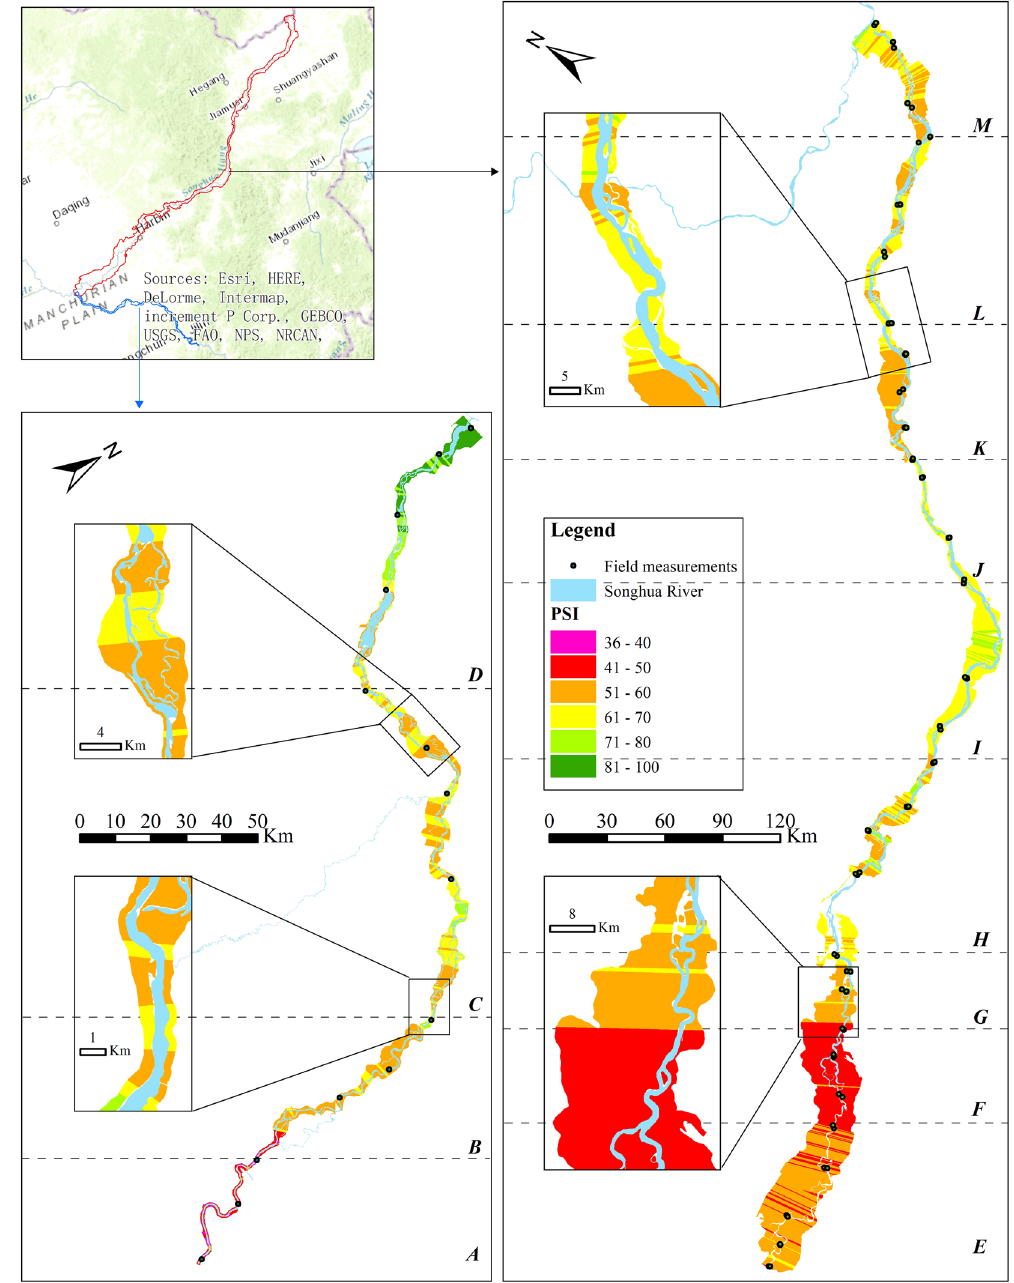
Figure 5. The spatial distribution of PSI values were derived from 2,081 BEUs. A-M represent the thirteen measurement sections. The map was prepared using ArcGIS 10.3 software (http://www.esri.com/software/ arcgis). The map is credited to: Esri, HERE, DeLorme, Intermap, increment P Corp., GEBCO, USGS, FAO, NPS, NRCAN, GeoBase, IGN, Kadaster NL, Ordnance Survey, Esri Japan, METI, Esri China (Hong Kong), swisstopo, MapmyIndia, © OpenStreetMap contributors, and the GIS User